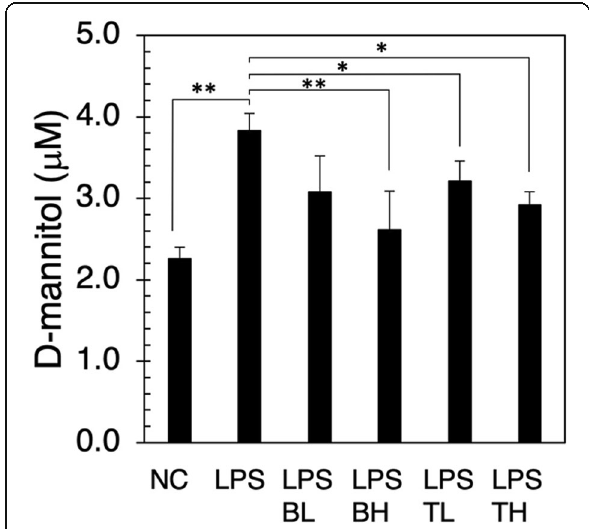
Fig. 3 Plasma D-mannitol concentration after D-mannitol